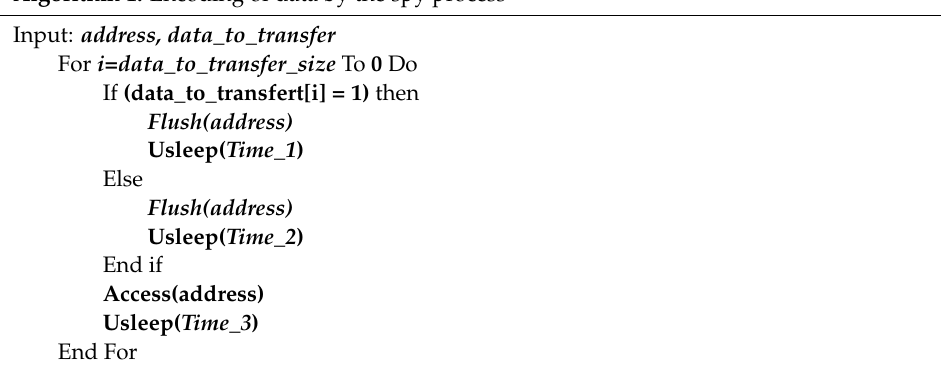
Algorithm 1: Encoding of data by the spy process